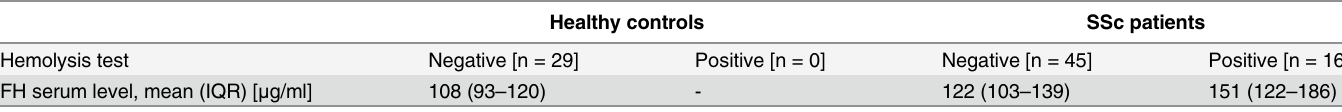
Table 2. Serum hemolytic activity in healthy subjects and SSc patients.